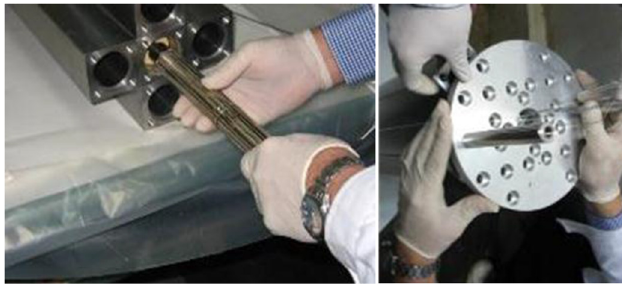
Fig. 2. MYRRHA fuel transient testing in TRIGA ACPR of ICN